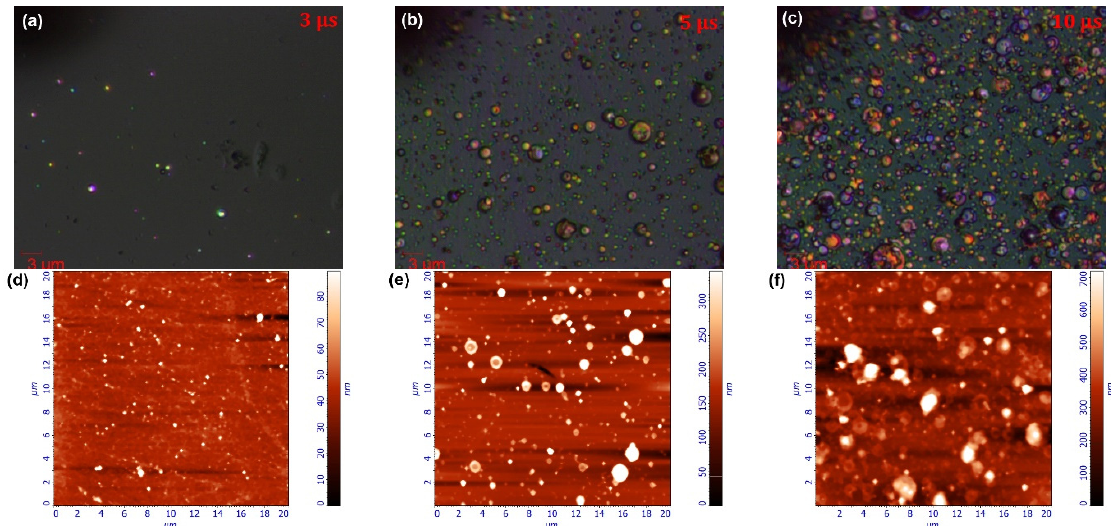
Figure 4. Optical micrographs ( a – c ) and AFM images ( d – f ) of SiO 2 thin films deposited by reactive HiPIMS for three selected pulse durations (3, 5, and 10 μ s).